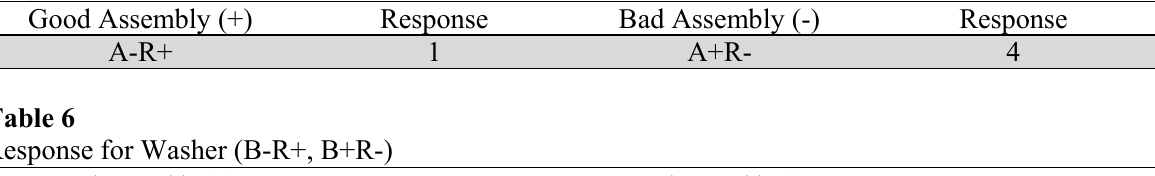
Response for Hook (A-R+, A+R-) Good Assembly (+)